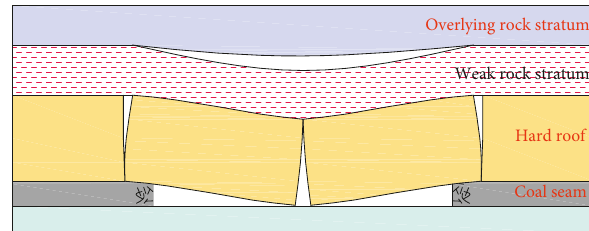
Figure 6: Status of the hard roof after the initial breakage event.